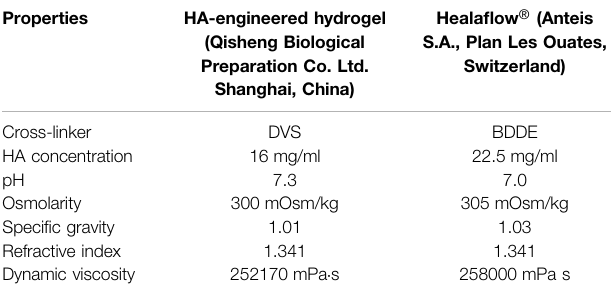
TABLE 1 | Comparison of physicochemical properties between the HA- engineered hydrogel and Heala fl ow ® .